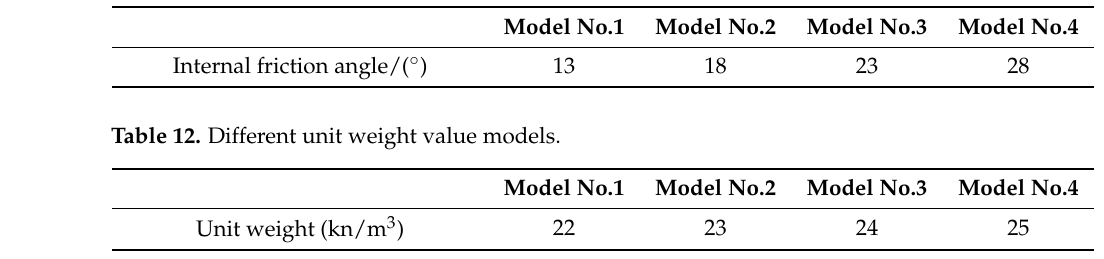
Table 11. Different internal friction angle value models.